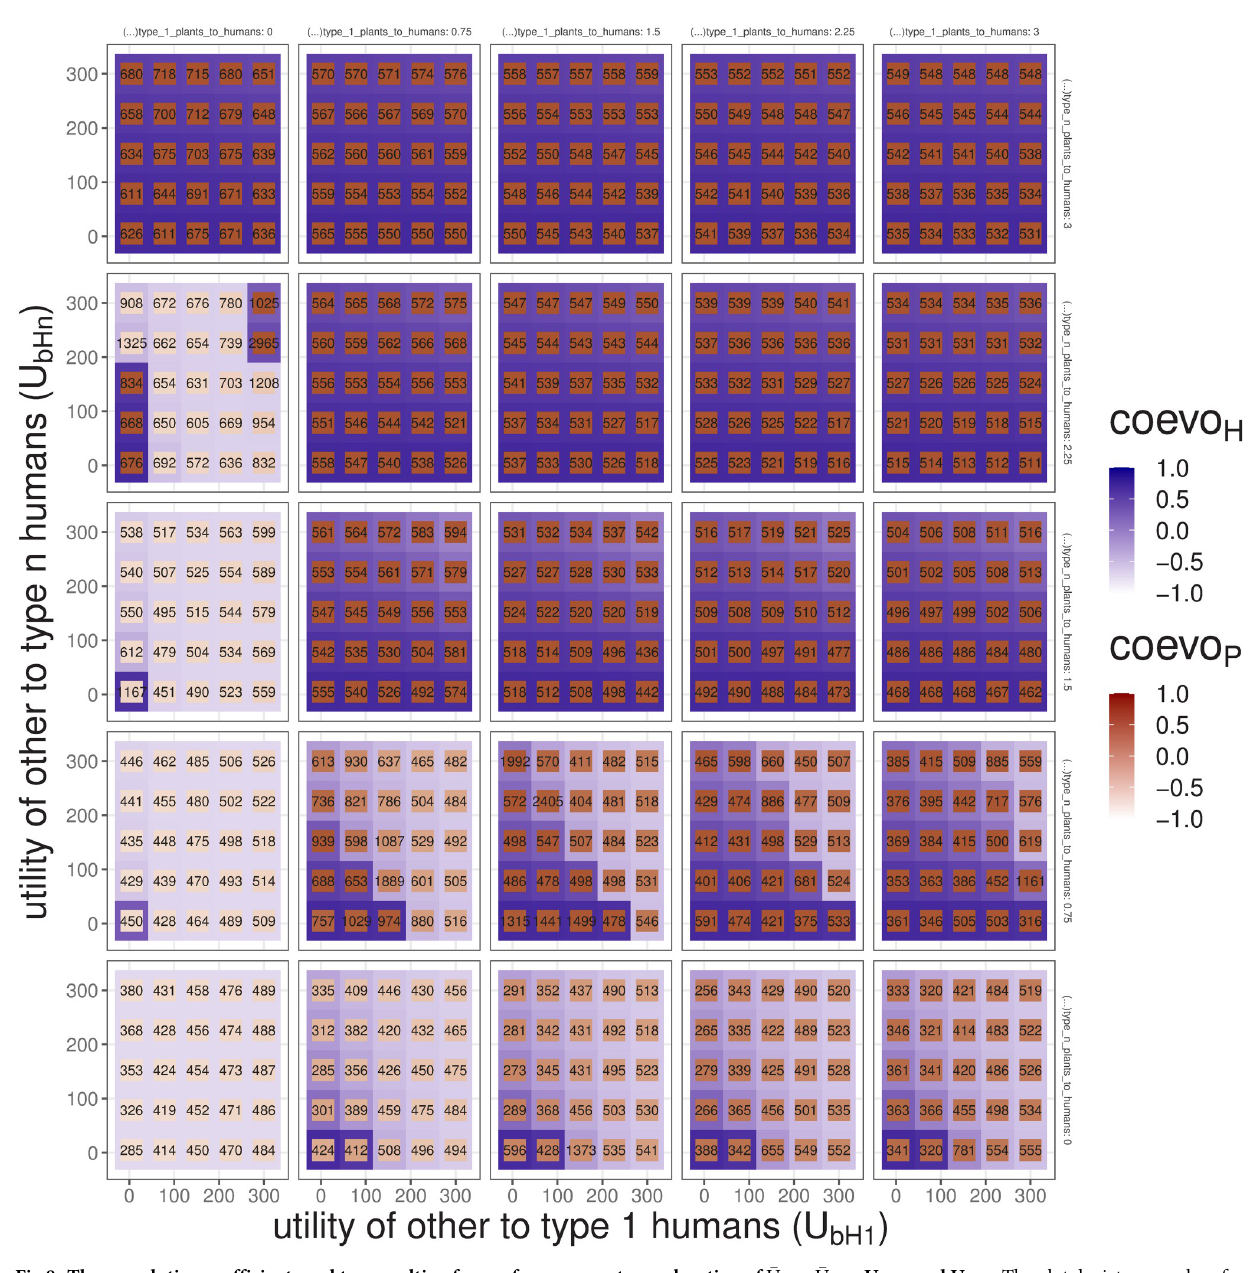
Fig 8. The coevolution coefficients and t end resulting from a four-parameter exploration of � U facilitators ( � U and � U ; values of large grid), and obstructors (U bH1 and U bHn ; values of small P 1 H P n H